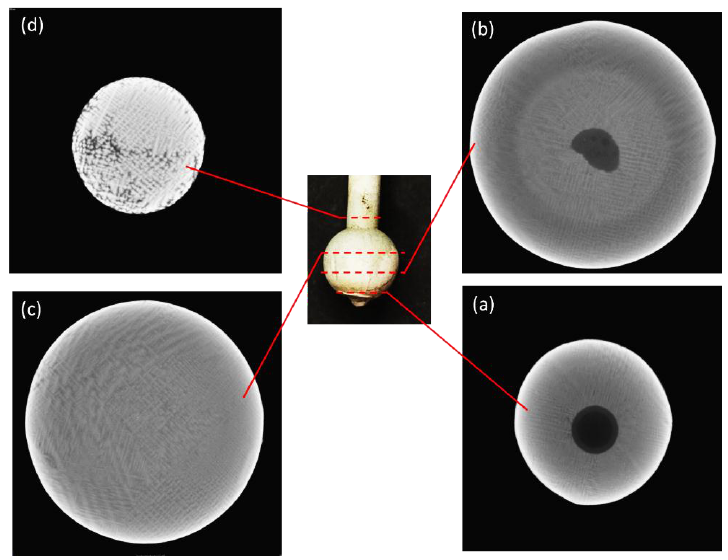
Figure 6. Intersections of the Ni9Re sample recorded with computer tomography. In ( a ), ( b ) and ( c ) a fine dendritic microstructure in the sphere is shown. In ( d ) a coarse microstructure above the sphere is visible.